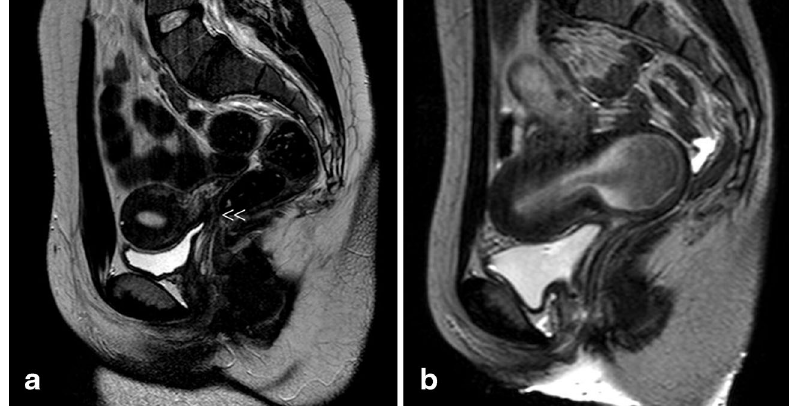
Fig. 7 Cases with vaginal or cervico-vaginal atresia or agenesis and normal uterine corpus. a T2-weighted MR image in a 20-year-old patient with complete cervico-vaginal atresia. Medial sagittal section